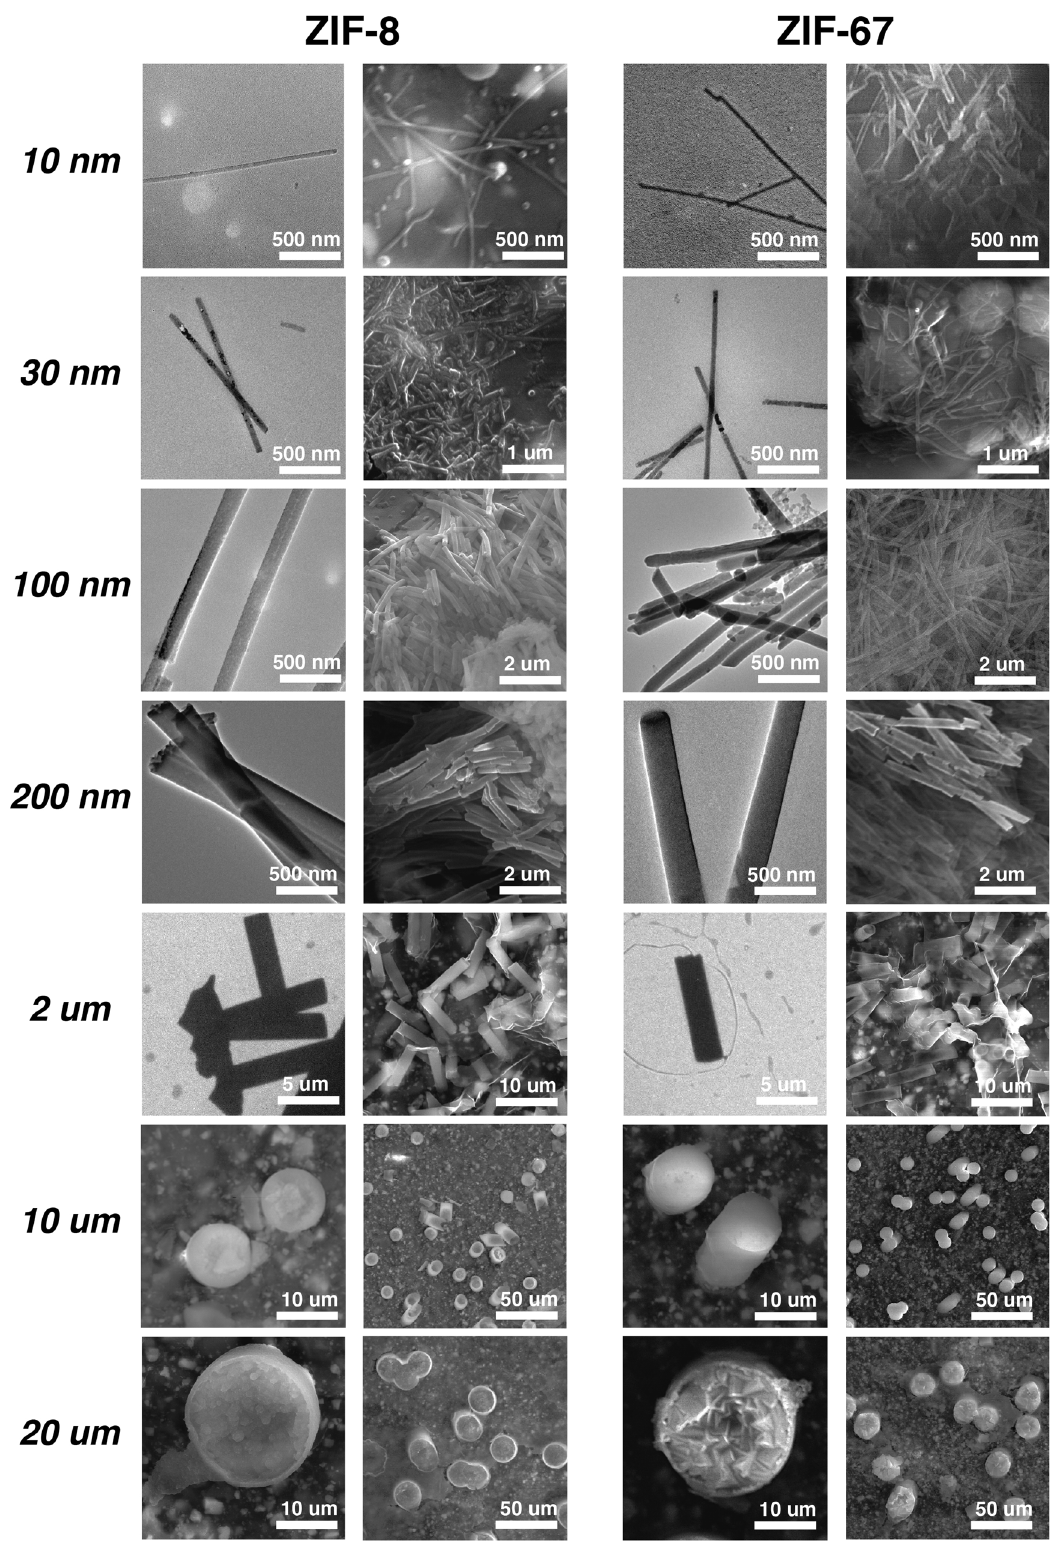
Fig. 4 Electron microscopy images of isolated nano- and micro-structures. Isolated structures by dissolution (left columns) and on conducting tape supports (right columns) for both ZIF-8 and ZIF-67, respectively. For dissolved structures, images for sizes 10 nm to 2 μ m are from transmission electron microscopy (TEM), while images for sizes 10 and 20 μ m are from scanning electron microscopy (SEM). Structures on conducting tape supports are all analyzed by